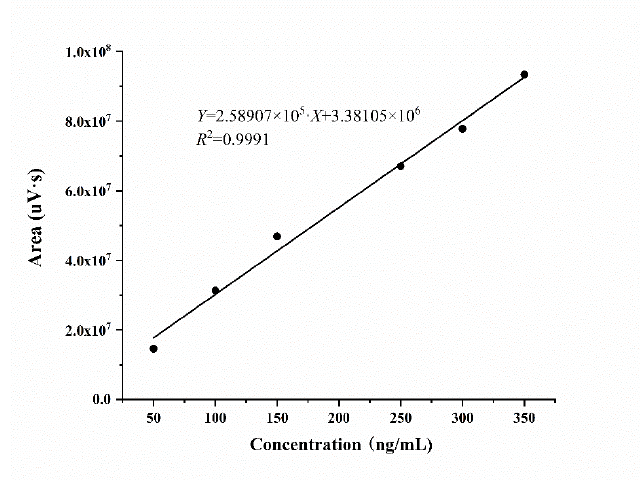
Figure 1. The standard curve of SW.